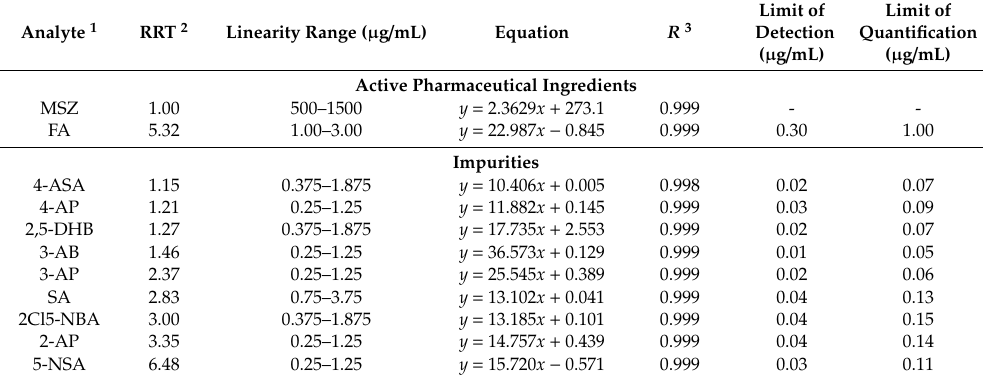
Table 1. Method calibration